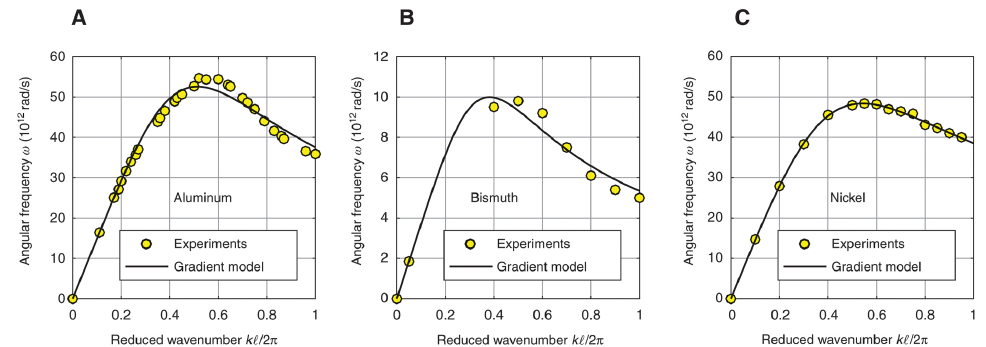
Figure 2: Experimental dispersion curves for aluminum, bismuth [3], [4] and nickel [5] vs. simulations with proposed gradient elasticity model.